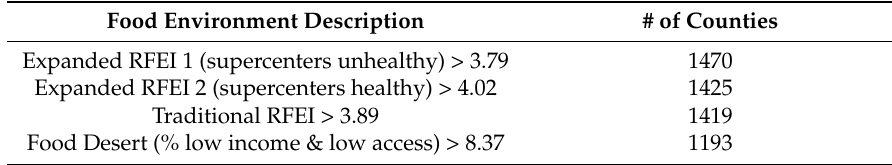
Table 4. Food Environment Measures ( N = 3108).